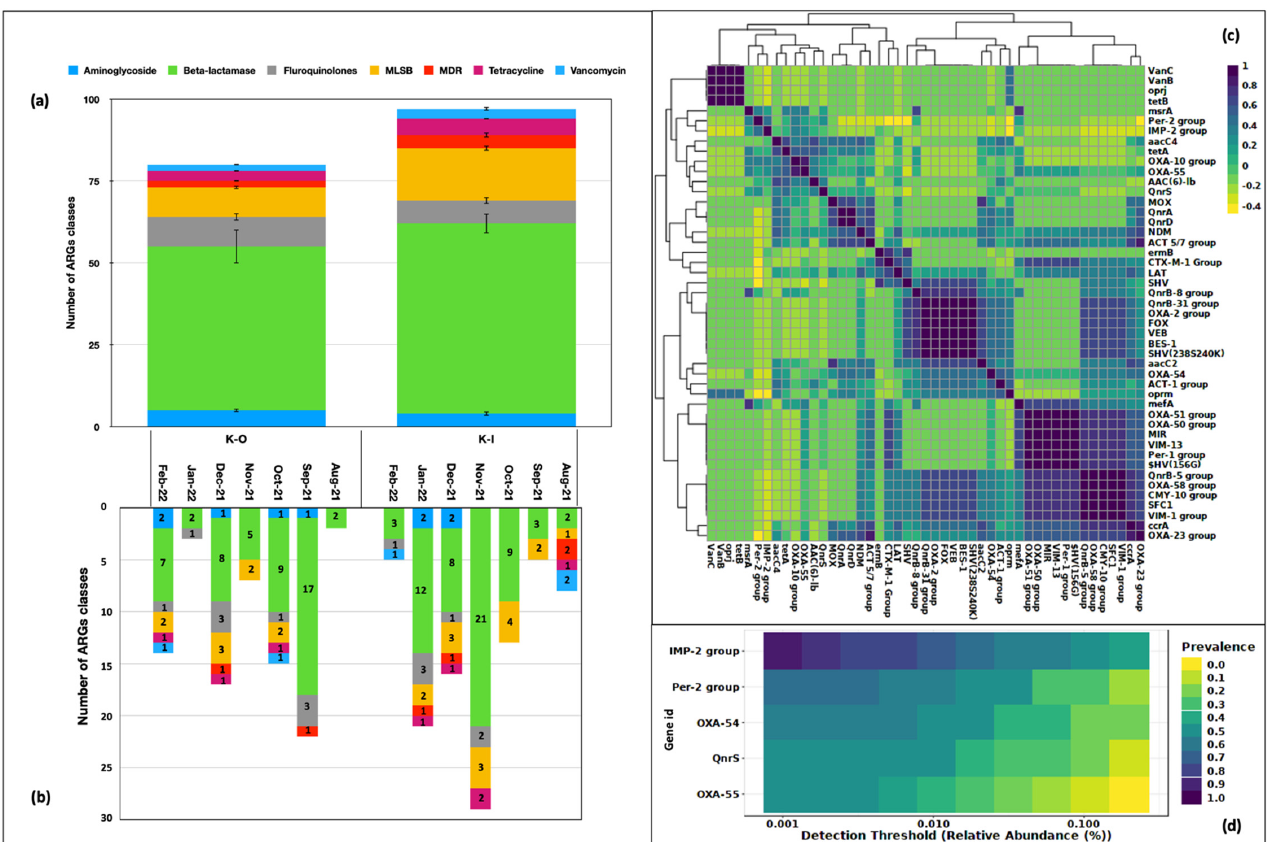
Figure 2. Drug classes identified in bioaerosols. ( a ) Number of ARG of each drug type in indoor and outdoor locations. ( b ) Category of ARGs in the respective month of sampling. ( c ) Types of ARGs. ( d ) Core resistome of bioaerosols.